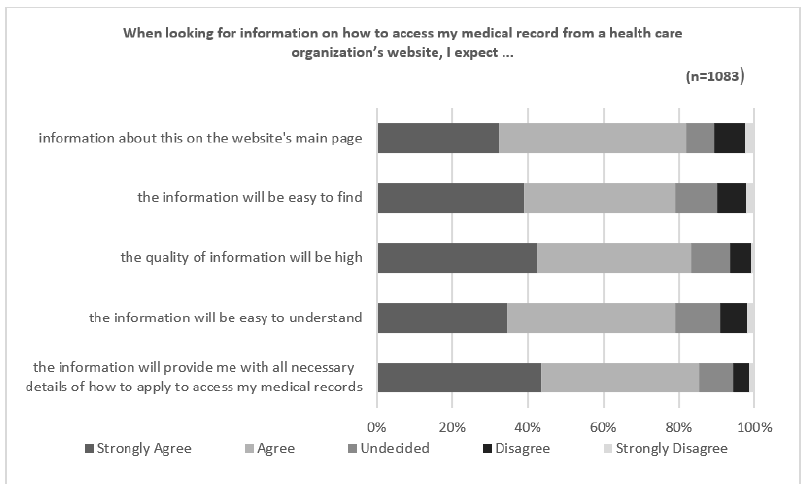
Figure 1. Expectations of health care organization websites.